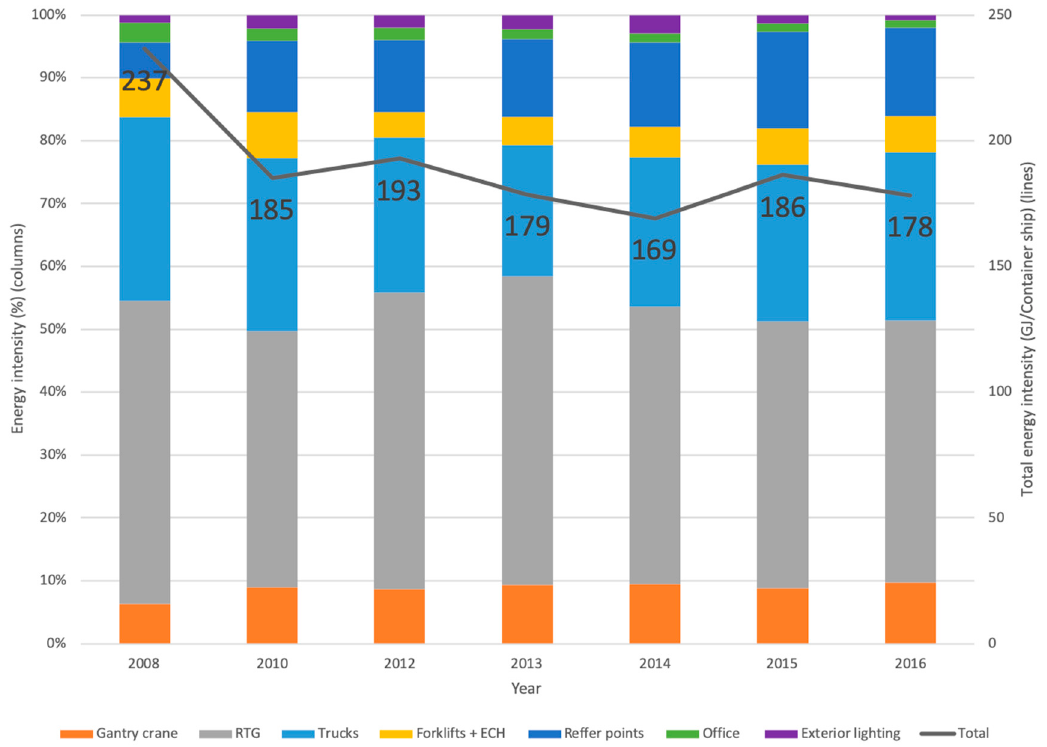
Figure 7. Energy intensity results for the case study using container ships as the functional unit.